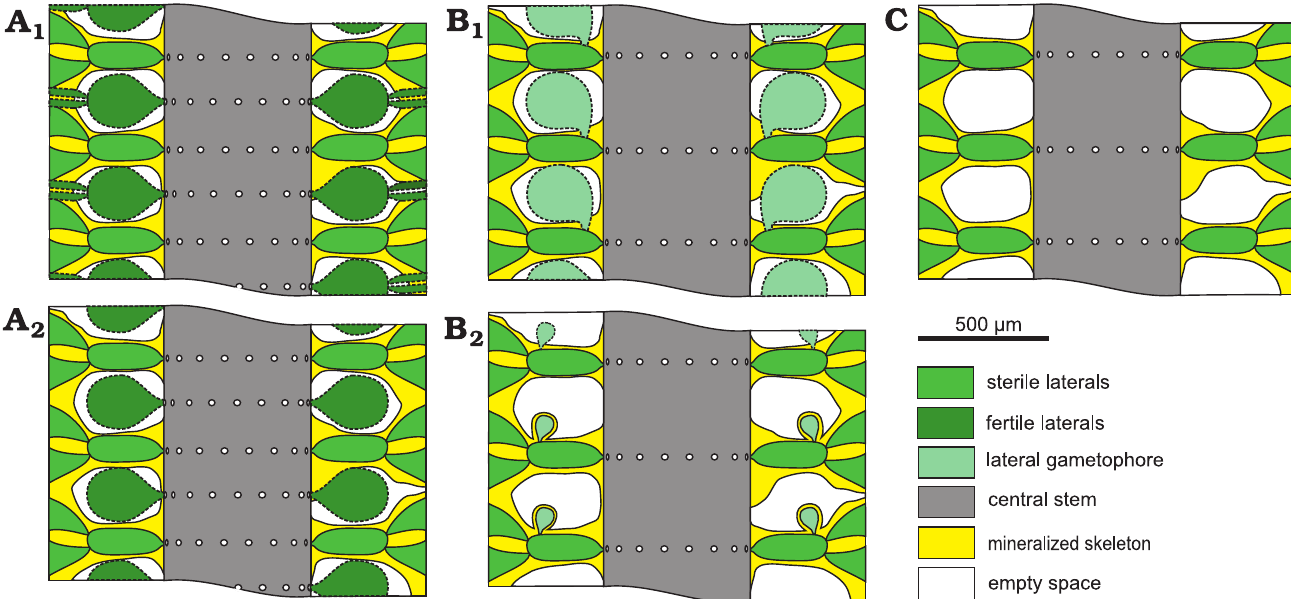
Fig. 3. Possible structural models in dasycladalean alga Chinianella ellenbergeri (Lebouché and Lemoine in Granier and Deloffre, 1994). A . Alternated whorls of weak/sterile and strong/fertile laterals; sterile and fertile laterals ramified (A 1 ); only sterile laterals ramified (A 2 ). B . Spaced whorls of weak/ster- ile laterals bearing a laterally attached gametophore (goniospory); large gametophore attached proximally (B 1 ); subterminal gametophore (B 2 ). C . Spaced whorls of weak/sterile laterals with simple interverticillar